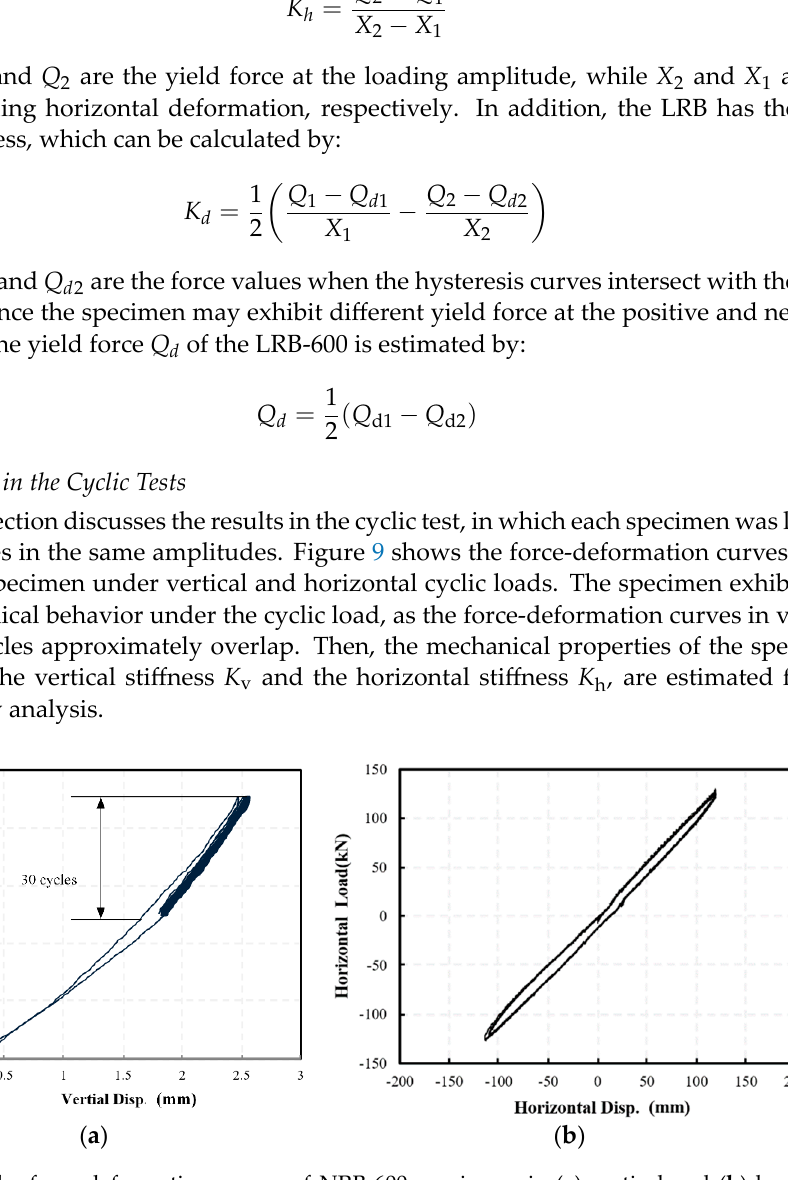
Figure 8. The force ‐ deformation curves of specimens under horizontal deformation of 50%, 100% and 150% shear strain: ( a ) NRB ‐ 600; ( b ) LRB ‐ 600. Table 5. Mechanical properties of the specimen obtained in the horizontal shear tests